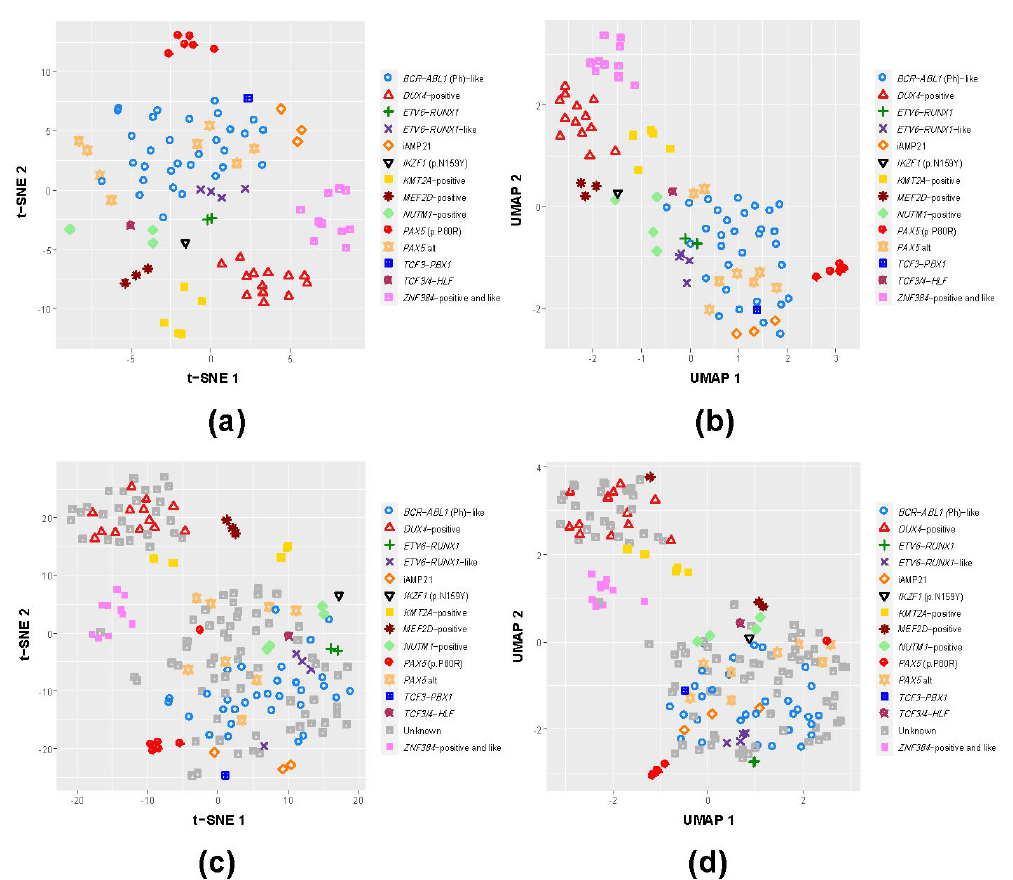
Figure 1. Whole-transcriptome expression data provides the means to cluster known BCP-ALL subgroups and tentatively classify co-clustering unknown samples. We used two dimensionality reduction visualization methods: t-Distributed Stochastic Neighbor Embedding (t-SNE; a , c ) and Uniform Manifold Approximation and Projection (UMAP; b , d ) for clustering the samples of the entire cohort, excluding the unknown samples ( a , b ) and including the unknown samples ( c , d ). Many unknown samples cluster with known subgroups, particularly DUX4 , thereby providing the means for tentative classification of such unknown (B-other)